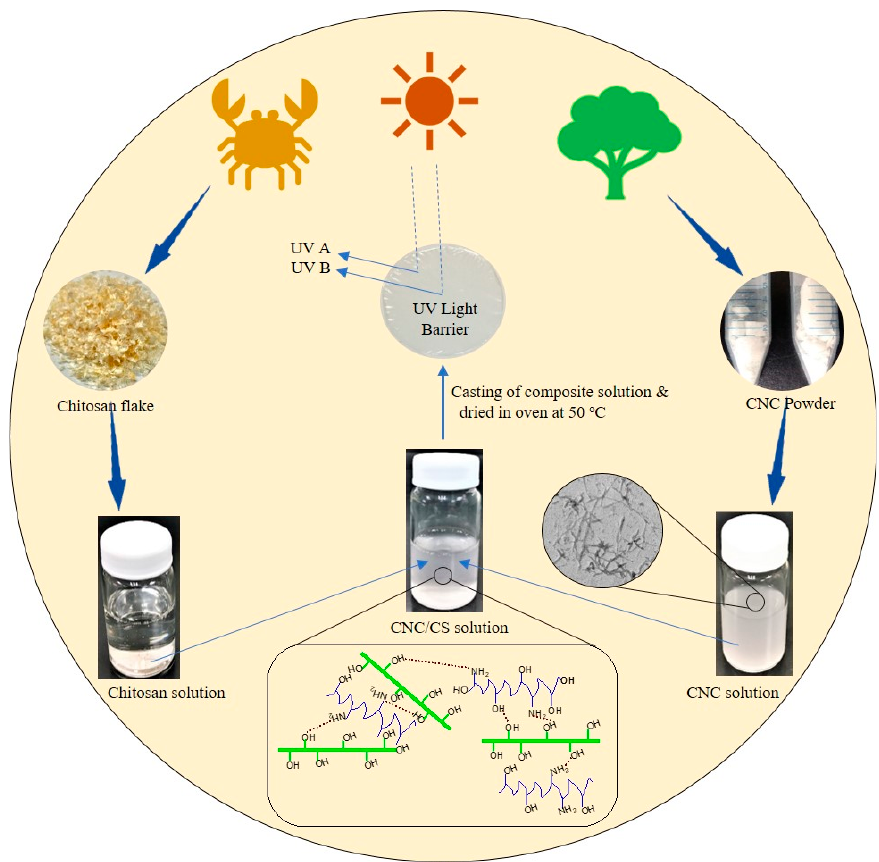
/ chitosan (CNC / CS) nanocomposite